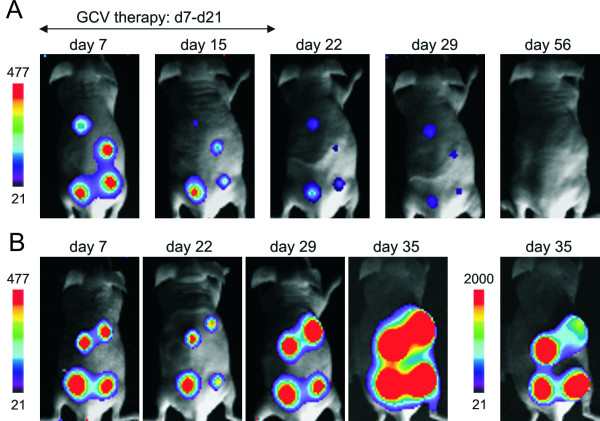
Bioluminescence imaging of nude mice carrying HSV-TK-Luc expressing U87MG gliomas. (A) Serial images from a mouse with 4 s.c. xenografts treated with GCV from day 7 to day 21 post tumor implantation and (B) saline treated control mouse, sacrificed on day 35 post tumor implantation due to massive tumor growth. The largest tumor in this mouse on the upper right back has already become necrotic. The day 35 image is also displayed at a broader grayscale range for better visualization of tumor localization. Note that control tumors also showed decreased light emission and a reduction in tumor size within the first 3 weeks post tumor implantation.